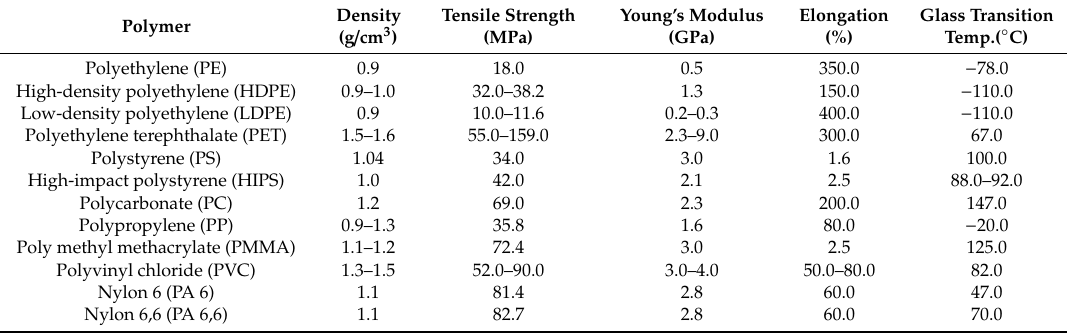
Table 8. Mechanical properties of thermoplastic resins.